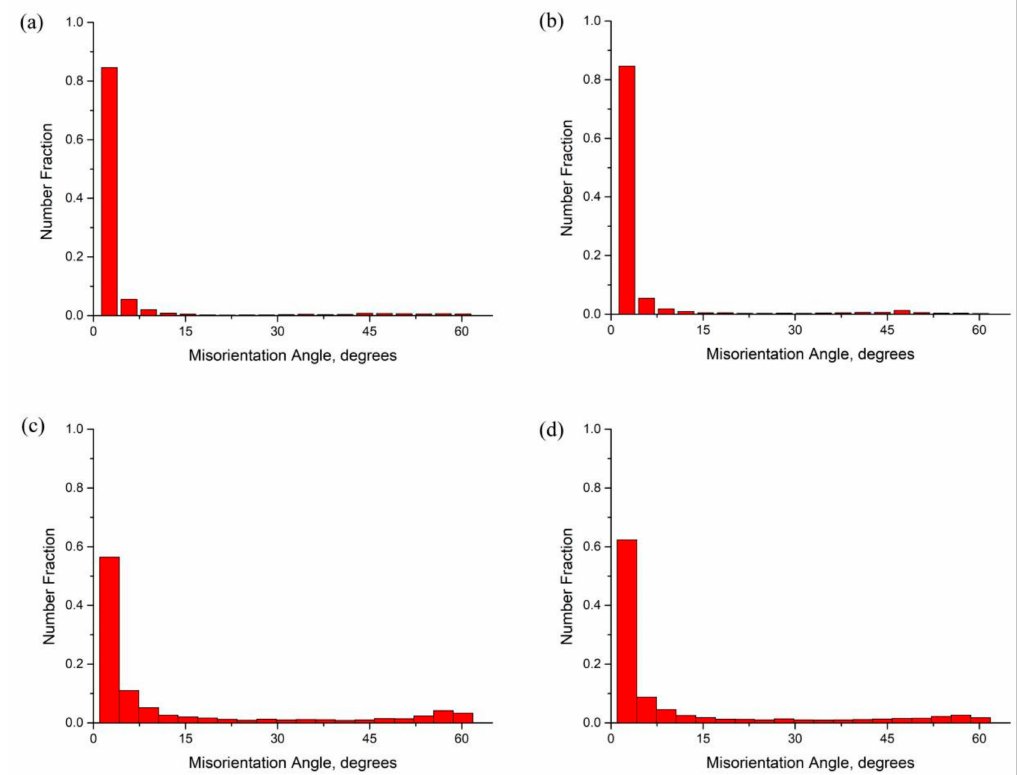
Figure 6. Misorientation angle distributions of Al-Zn-Mg-Cu-Zr alloy in the central layer ( a ), Al-Zn-Mg-Cu-Sc-Zr alloy in the central layer ( b ), Al-Zn-Mg-Cu-Zr alloy in the surface layer ( c ), and Al-Zn-Mg-Cu-Sc-Zr alloy in the surface layer ( d